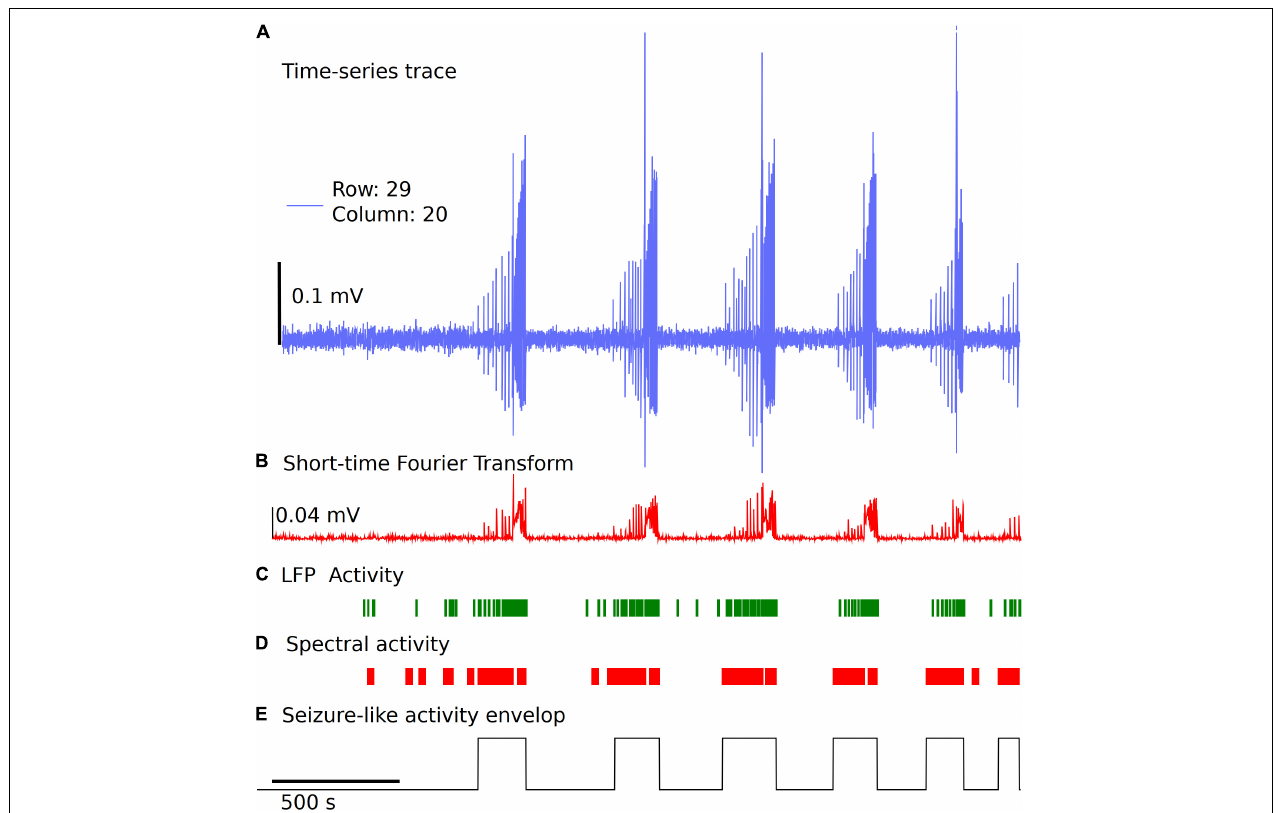
FIGURE 5 | Simple and fast unsupervised seizure detection method. (A) The raw trace from the recording downsampled to 300 Hz frequency for a sample channel. (B) Spectral activity calculated from the Short-time Fourier Transform using Hanning Window, for a time window of 1 s with no overlap. (C) LFP activity is detected using a threshold of 6 standard deviations from the baseline voltage for each individual channel and a fixed duration of 0.035 s, followed by applying two sets of sliding windows (length 30 datapoints and 500 datapoints) to detect time regions of continuous activity. (D) Spectral activity is detected when the magnitude is greater than mean + 6 standard deviations from the baseline spectrum magnitude. The spectral activity is also passed through two sliding windows to detect regions of continuous spectral activity. (E) The overlapping regions of LFP activity and spectral activity of 10 s or more are used to identify the seizure envelop. The start of seizure is primarily identified using the time point when the spectral activity is greater than 6 standard deviations from the